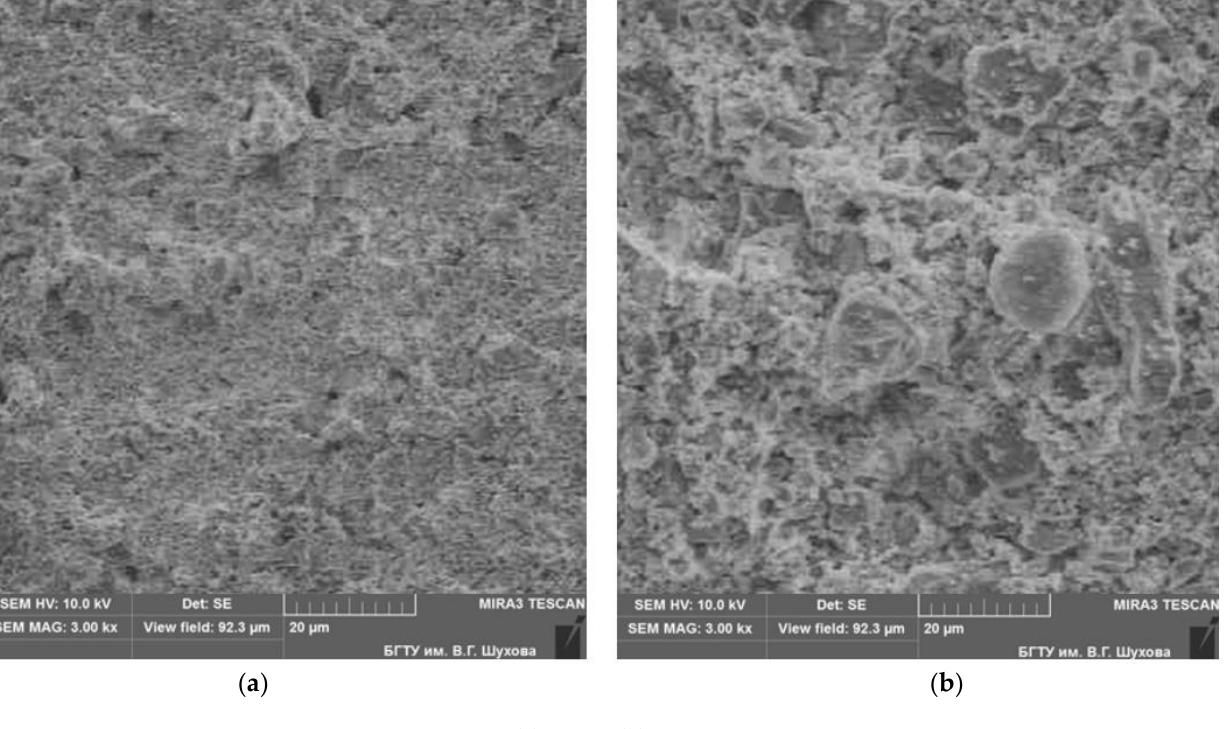
Figure 10. SEM images: ( a ) mix A; ( b ) mix B. Table 12. Relationship between rheological and strength characteristics of a